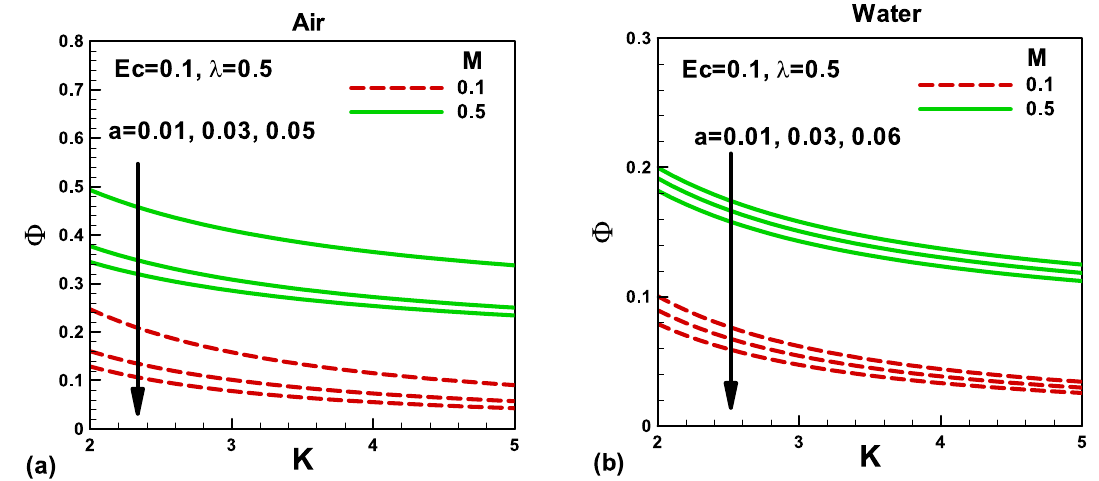
Figure 15. Effects of magnetic and porosity parameters on irreversibility distribution ratio for (a) air and (b) water, when both needle and fluid are moving in the same direction.